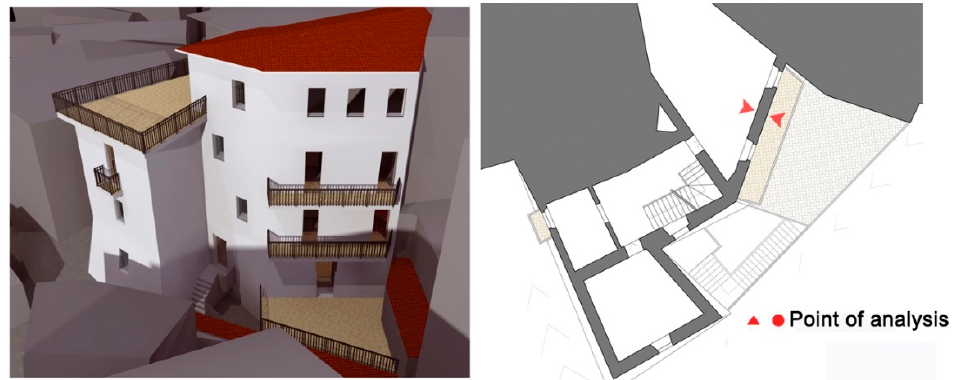
Figure 7. Point where the measurement was performed.